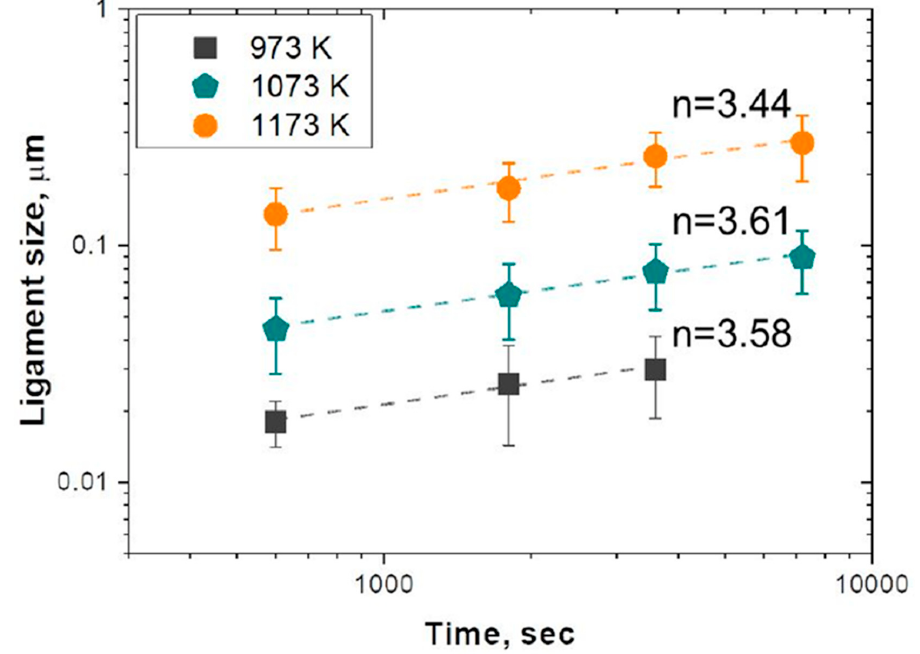
Figure 6. Ligament size in a TiVNbMoTa nanoporous high entropy alloy (HEA) versus dealloying time at various temperatures. The dealloying time, t , and ligament size, d , are correlated through a power function d n = ktD , where n is the coarsening component, k is a constant, and D is the surface di ff usivity. By plotting the ln [ d ( t )] vs. ln t curve, the coarsening exponent, n , can be obtained. Error bars denote the distribution of ligament sizes. (Figure reprinted from [55] with permission from Wiley,